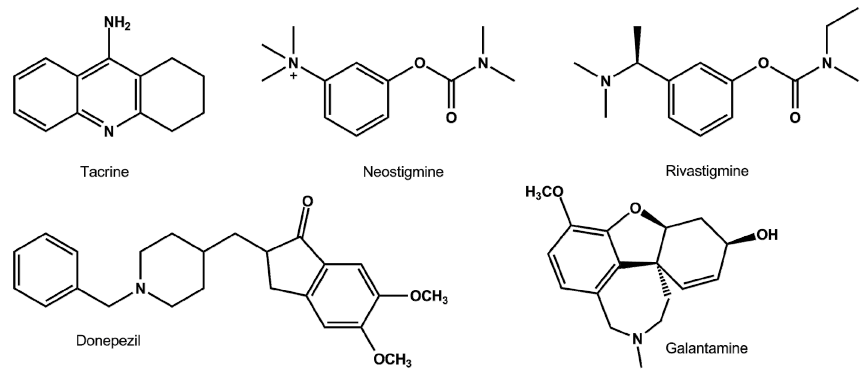
Figure 1. Structures of cholinesterase inhibitors used as therapeutics in Alzheimer’s disease.